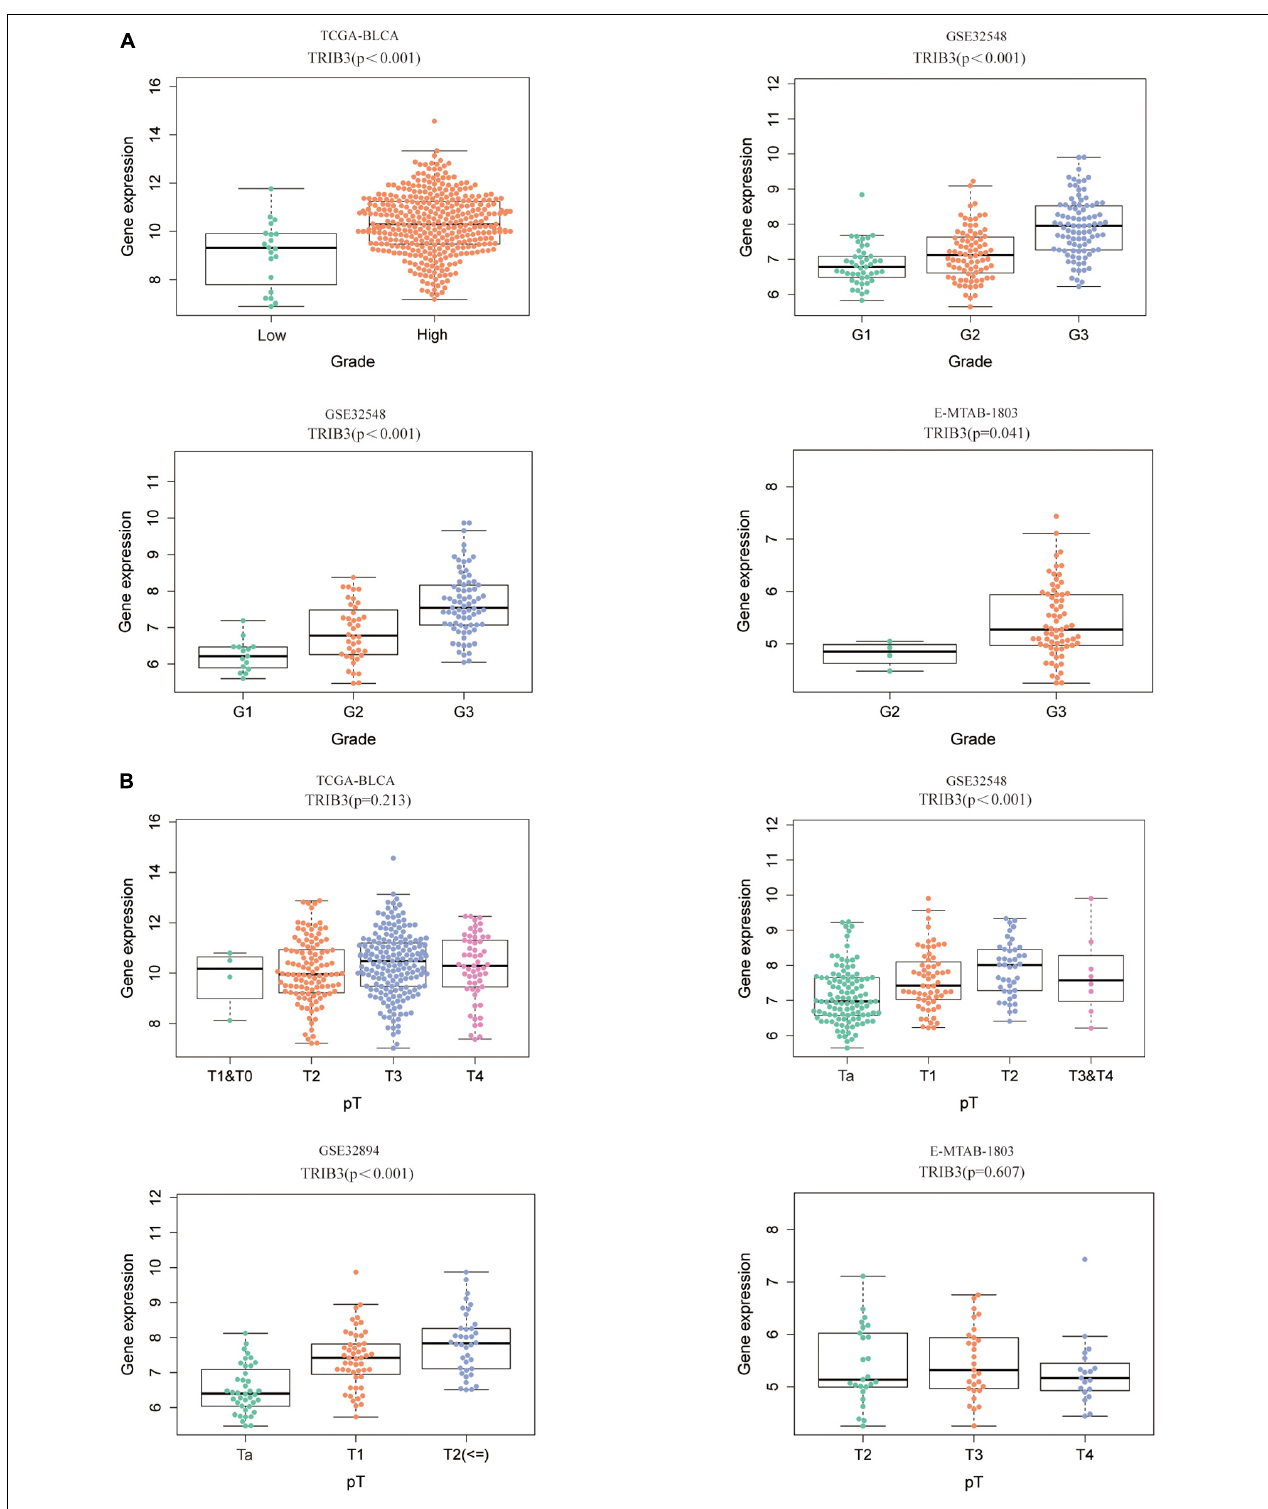
FIGURE 3 | The expression of TRIB3 in various clinical types. (A) The expression scatters the plot of TRIB3 under different grades in four cohorts. (B) The expression scatters the plot of TRIB3 under different T stages in four cohorts.